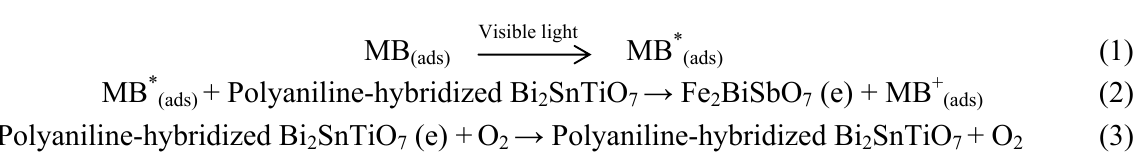
Scheme 2. Photosensitization effect by the dye